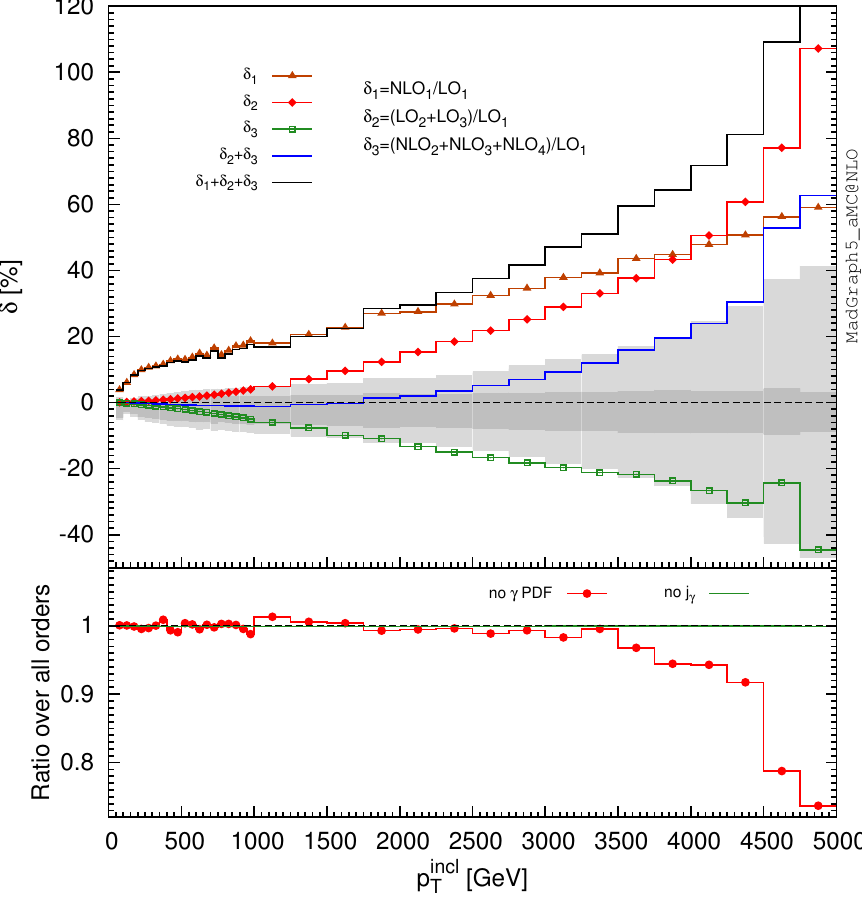
Figure 3 . Single-inclusive transverse